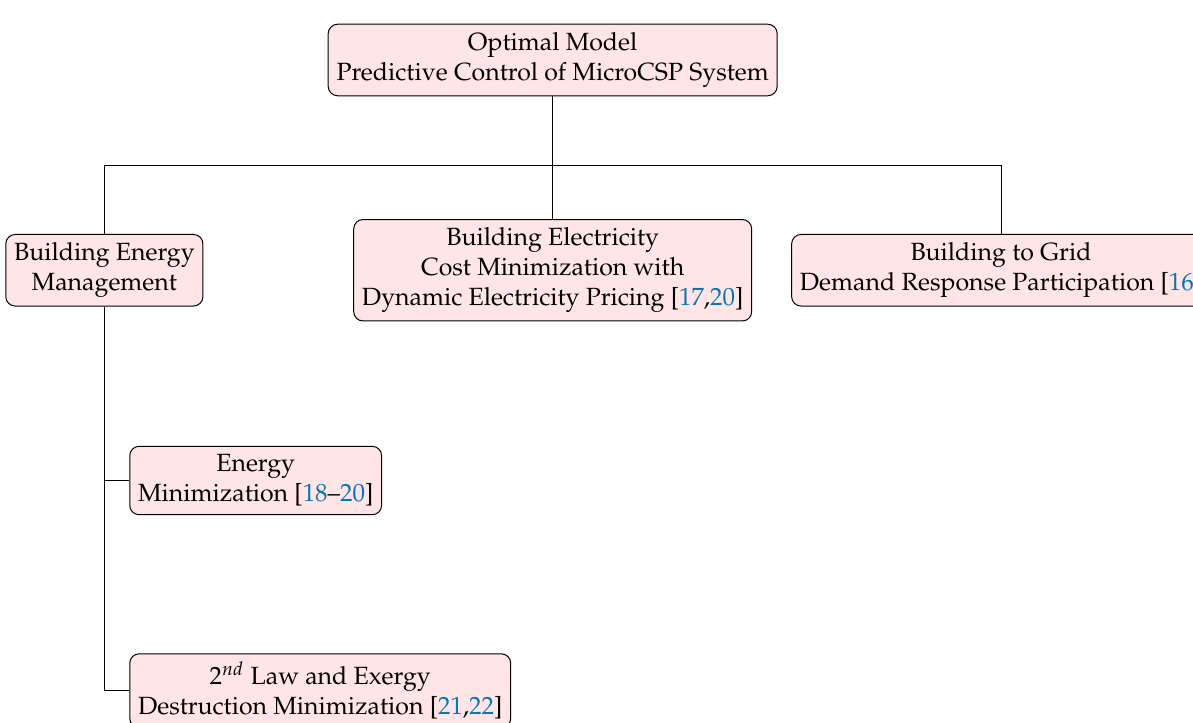
Figure 12. Classification of MPC frameworks for MicroCSP integrated into building HVAC